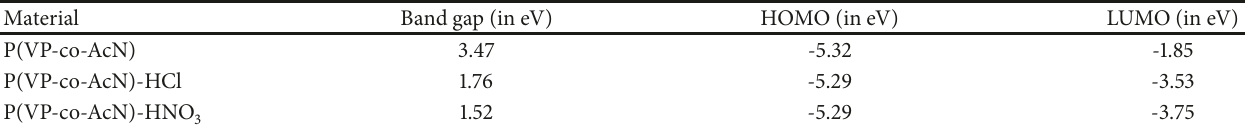
Table 1: The different energy levels and the band gap of the copolymer and the polyelectrolytes.